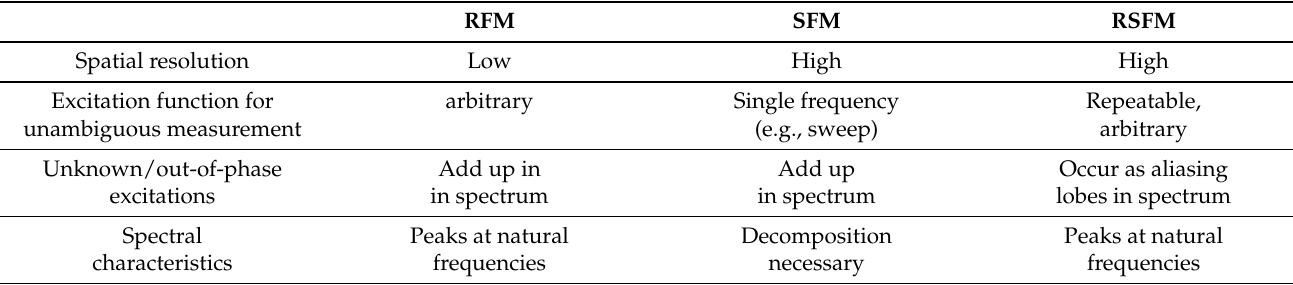
Table 2. Comparison between a rotating frame measurement (RFM), a stationary frame measurement (SFM) and a rotating frame measurement from the stationary frame (RSFM) RFM SFM RSFM Spatial resolution Low High High Excitation function for arbitrary Single frequency Repeatable, unambiguous measurement (e.g., sweep) arbitrary Unknown/out-of-phase Add up in Add up Occur as aliasing excitations in spectrum in spectrum lobes in spectrum Spectral Peaks at natural Decomposition Peaks at natural characteristics